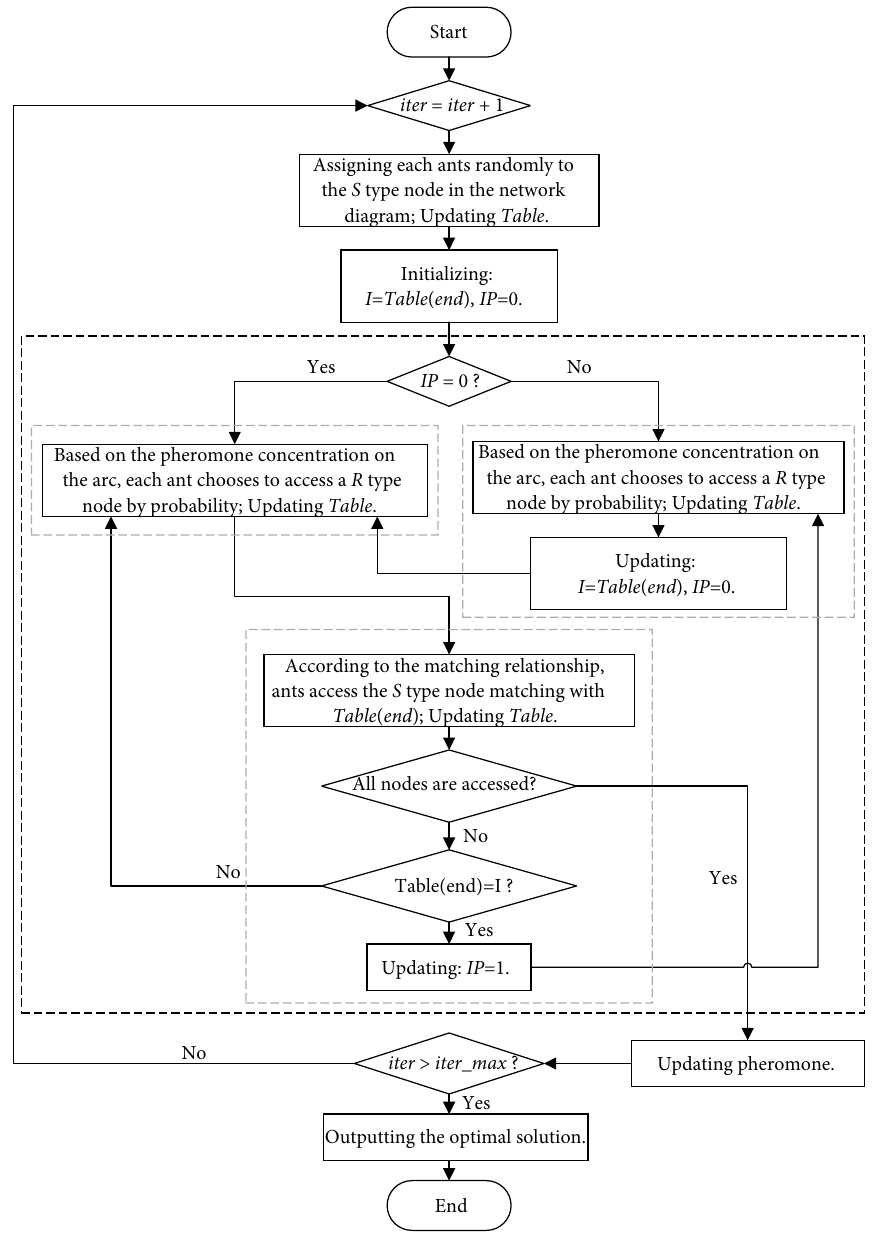
Figure 6: The flow chart of ant colony